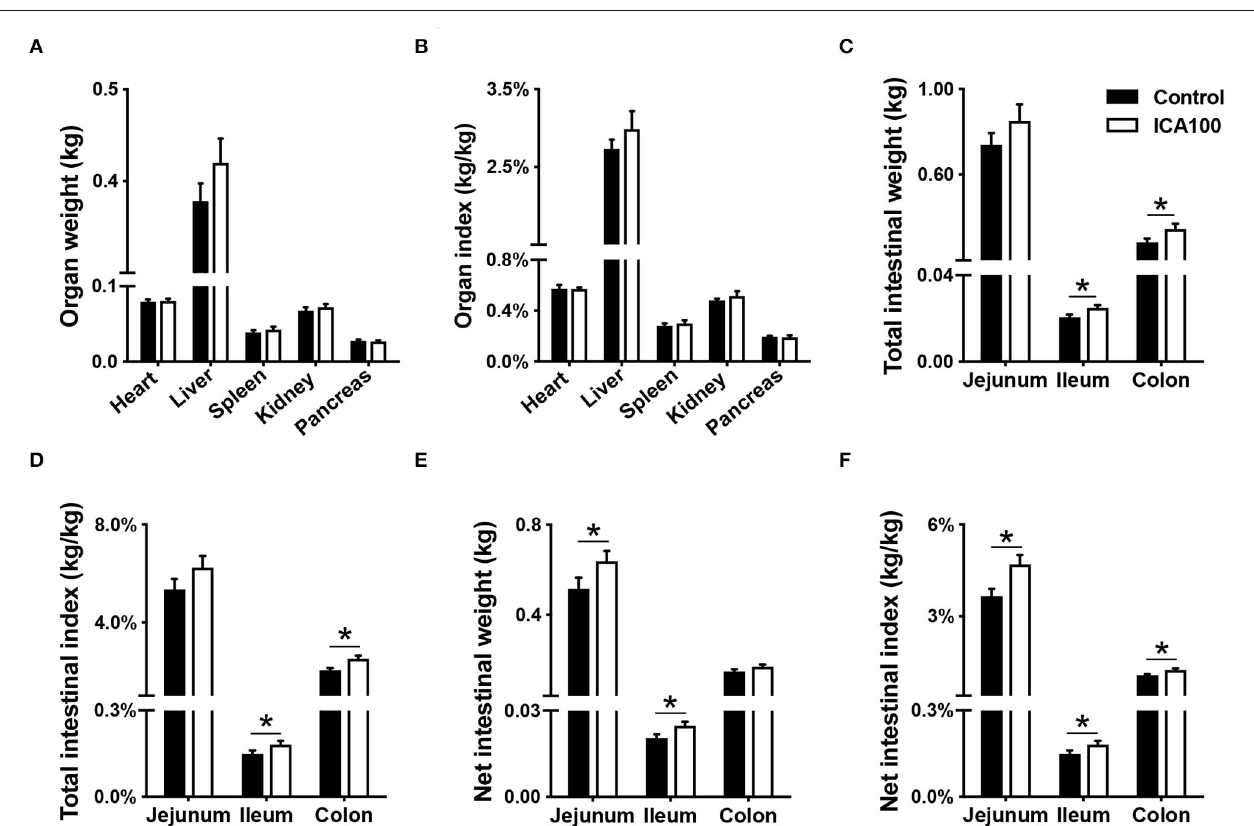
bicinchoninic acid (BCA) protein assay kit (#A045-4-2,